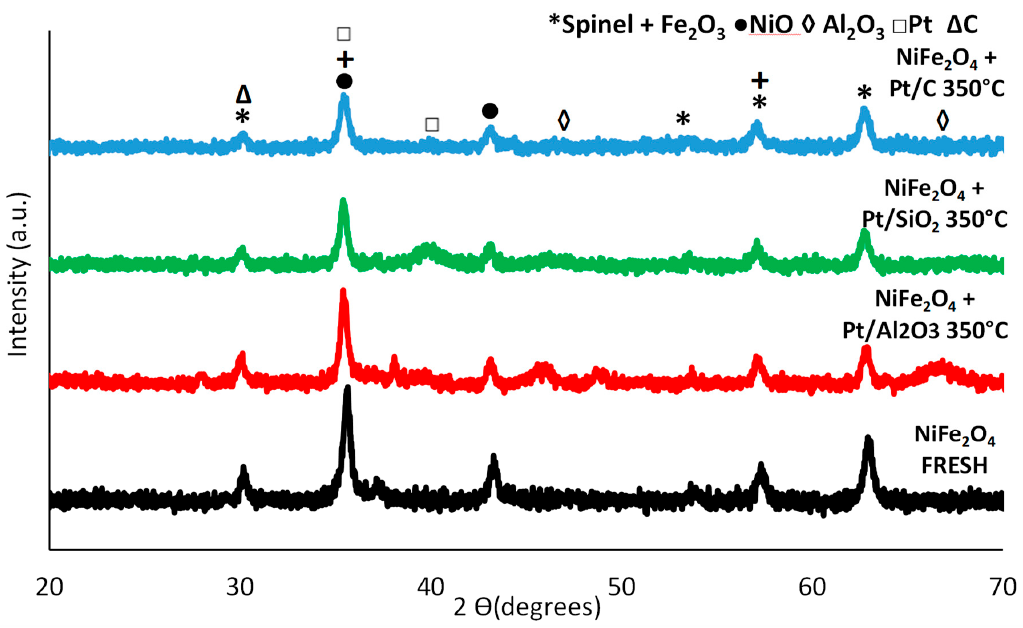
Figure 9. XRD of the fresh and recovered NiFe 2 O 4 -Pt/C, NiFe 2 O 4 -Pt/Al 2 O 3 and NiFe 2 O 4 -Pt/SiO 2 .